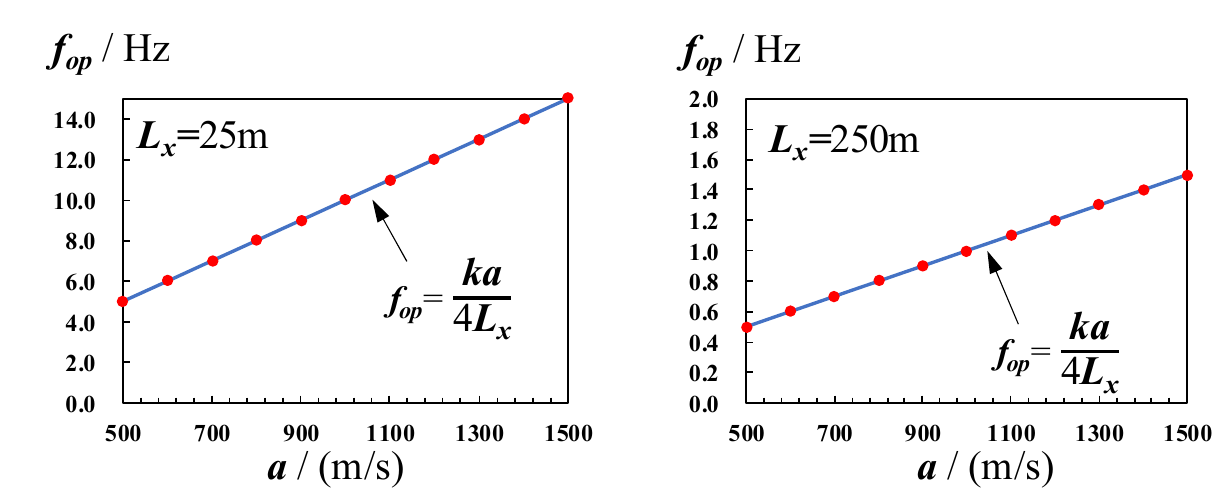
Figure 13. Relationship between the optimal pulse frequency and wave speed with different pipe lengths. The left data points are obtained when the pipe length is 25 m, and the right data points are obtained when the pipe length is 250 m. Here k = 1 is taken as an example.